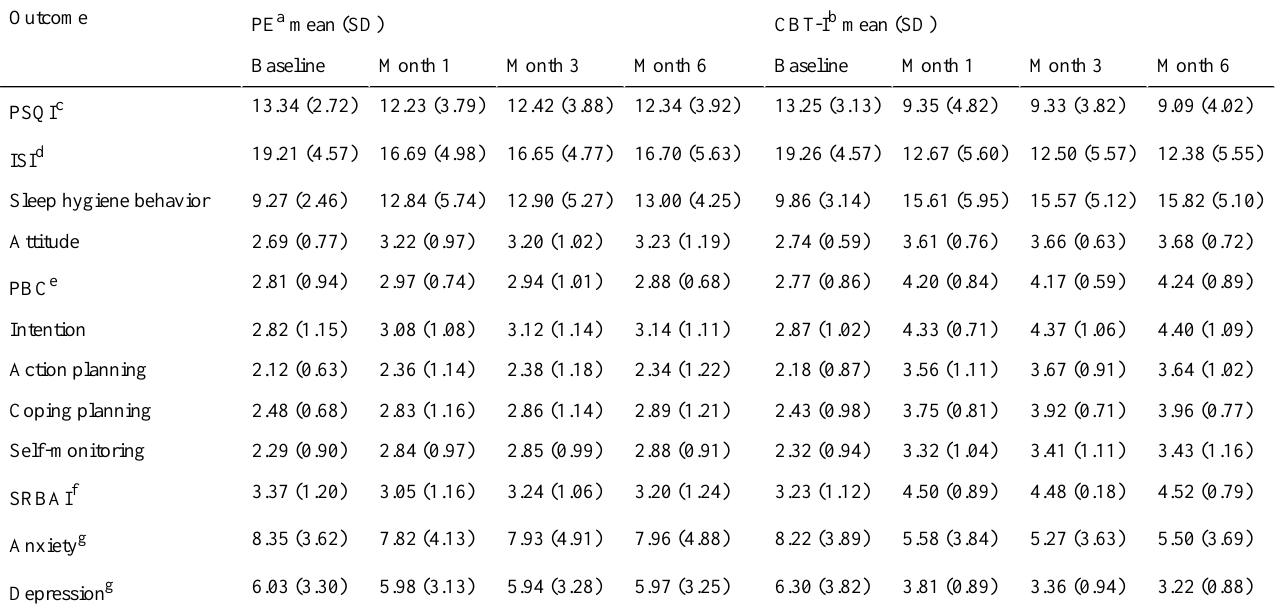
Table 3. Descriptive statistics for all outcome measures by condition and